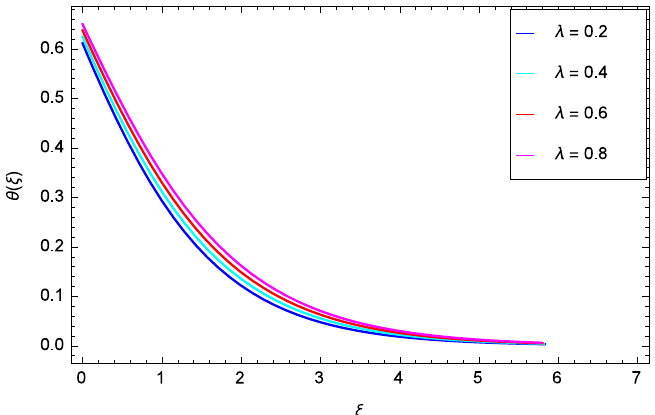
Figure 11. Impact of the heat dissipation parameter λ on temperature θ ( ζ )